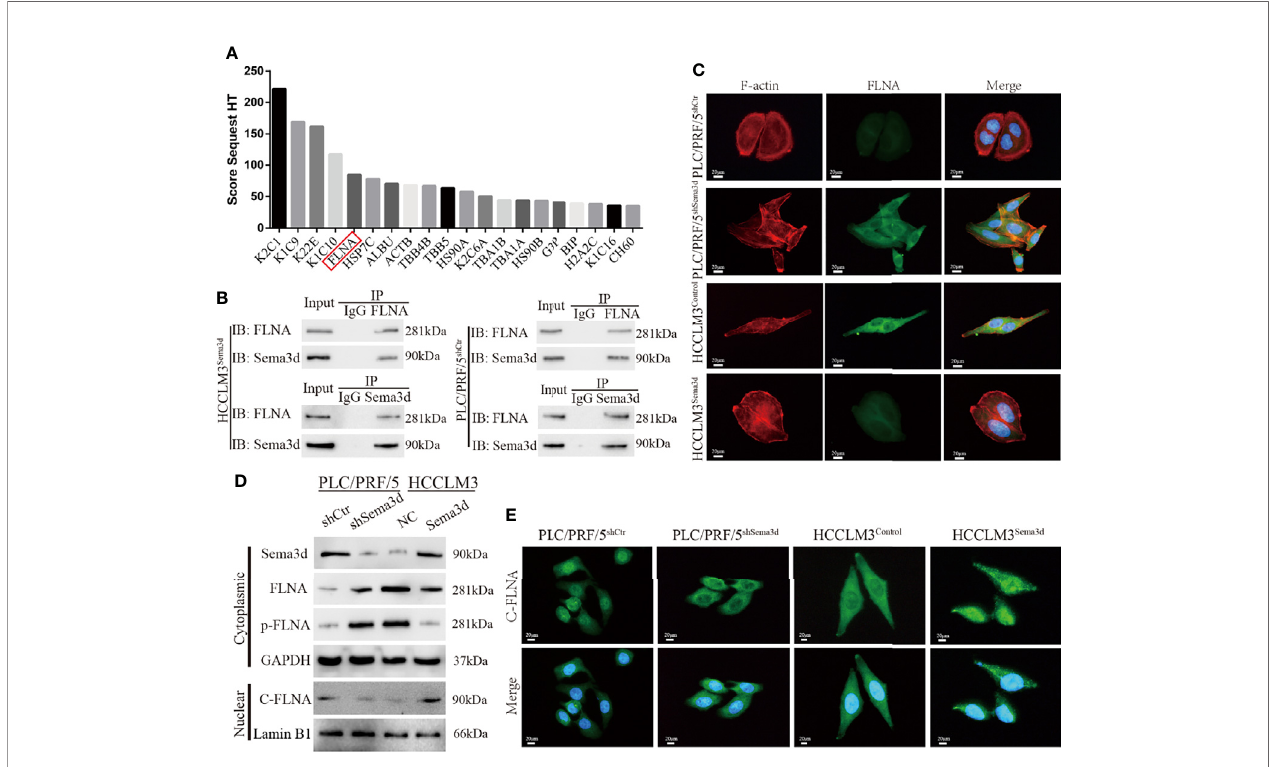
FIGURE 5 | Sema3d directly interacts with FLNA and affects cytoskeleton remodeling. (A) Coimmunoprecipitation (co-IP) was performed to extract Sema3d direct combined proteins from HCCLM3 Sema3d cells, which were then identi fi ed using LC-MS/MS. The top 20 combined proteins sorted by Score Sequest are shown in the diagram. (B) co-IP was performed to determine that Sema3d and FLNA could directly interact with each other. (C) Double immuno fl uorescence staining showed that Sema3d affected the cellular expression of FLNA (green) and induced cytoskeleton remodeling (F-actin, red). (D) Protein expression levels were analyzed by Western blot and showed that Sema3d regulated the phosphorylation level of FLNA and the amount of nuclear C-FLNA. (E) Immuno fl uorescence staining revealed that Sema3d promotes C-FLNA translocated from the cytoplasm to the